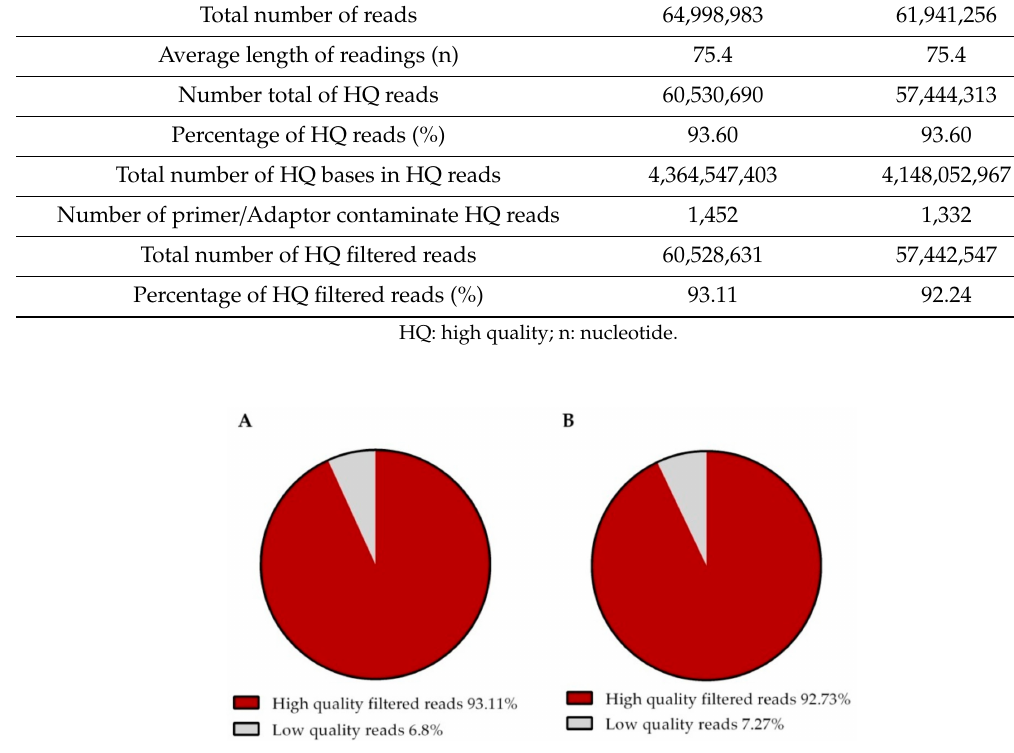
Figure 1. Composition total raw reads of the quality control (QC) that represents the percentage of readings of the groups: ( A ) Summary of quality check and filtering in multiparous sheep; ( B ) Summary of quality check and filtering in uniparous